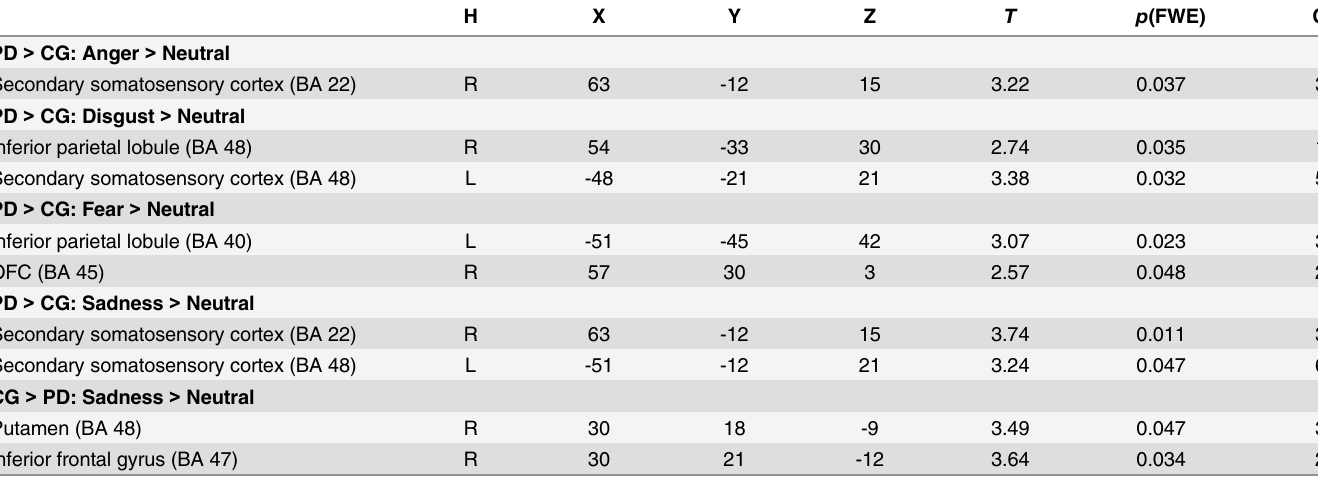
Table 2. Comparison of brain activation in the emotion conditions between patients with Parkinson ’ s disease (PD) and the control group (CG). H X